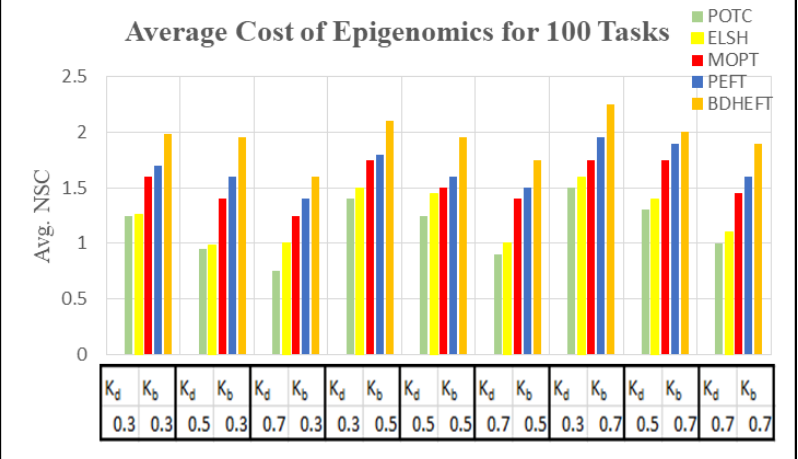
Figure 13. Average execution cost of the epigenomics workflow for different deadline factors.